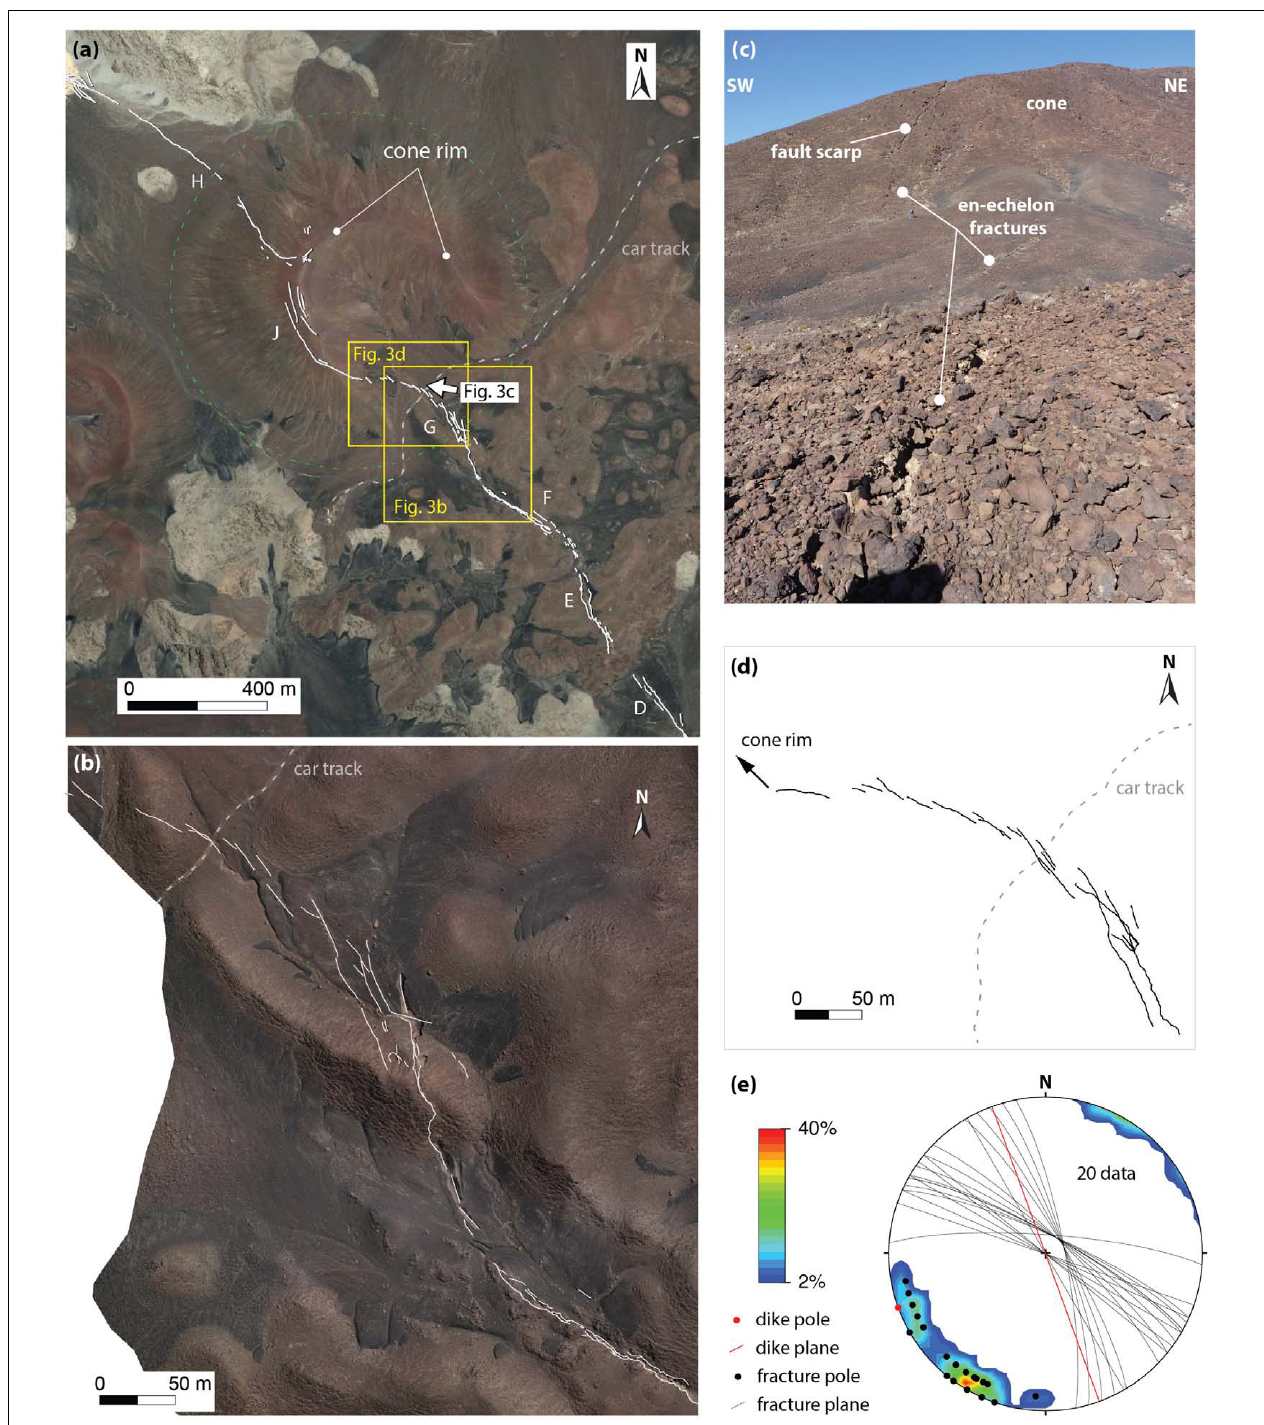
FIGURE 3 | Fracture patterns of the western fault where it intersects a scoria cone. (a) Mapped fractures (white lines) on a background satellite image (Bing Map) (map area coverage shown in Figure 2 ). Green dashed circle indicates the approximate base of the cone. (b) En-echelon fracture patterns (white lines) just south of the cone. The background is the drone ortho-photo combined with the digital elevation model. (c) Photo taken in the field toward the cone showing the surface expression of the western fault where it intersects the southern slopes of the cone (photo location and azimuth indicated by an arrow in Figure 3a ). (d) Fracture patterns (black lines) south of the cone mapped using kinematic GPS. (e) Stereonet of field measurements showing fracture planes and the associated poles. The pole color density was obtained with the 1% area method (%value = n (100)/N where n is the number of points falling within an area of the plot and N is the total number of points). The stereonet was obtained using the Stereonet software by Allmendinger et al. (2012) and Cardozo and Allmendinger (2013).